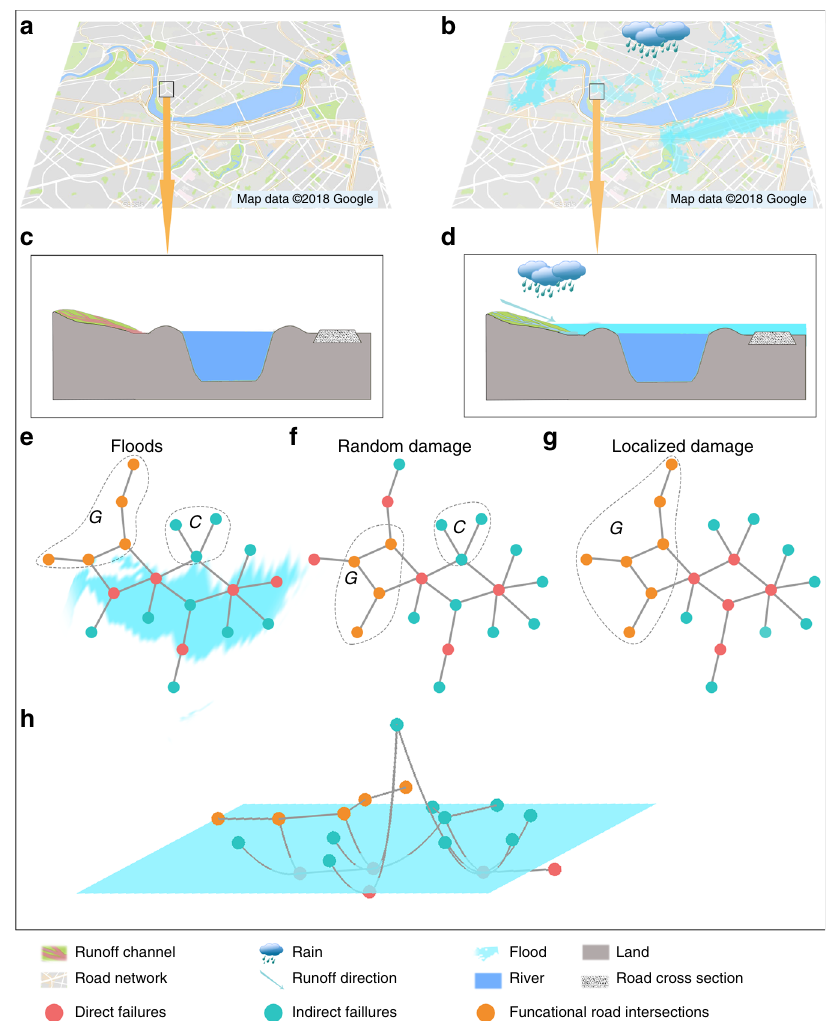
Fig. 1 Schematic diagram of fl oods and demonstration of the effects of fl oods, random damage, and localized damage on a road system. a River and road network without fl ooding. b River and road network when rainfall-induced fl ooding inundates some road segments. c Sectional view of the boxed region in a . d Sectional view of the boxed region in b . The rainfall forms runoff on the ground. A large amount of runoff converges into a fl ood and inundates some road segments. The fl ood follows the river channel and damages infrastructure (e.g., roads) in a river basin. The fl ood-induced failures have a distinct trajectory. Schematic demonstrations of ( e ) random damage and ( g ) localized damage in a sketched network respectively. f 2D and h 3D views of fl ood disturbance in the sketched